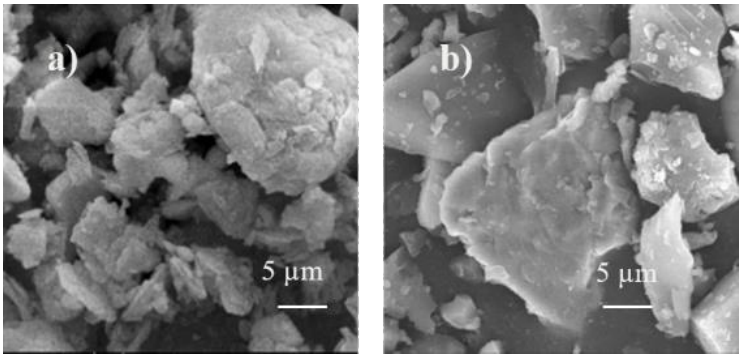
Figure 3. SEM image of raw materials: ( a ) polyaluminum chloride slag; ( b ) glass powder.